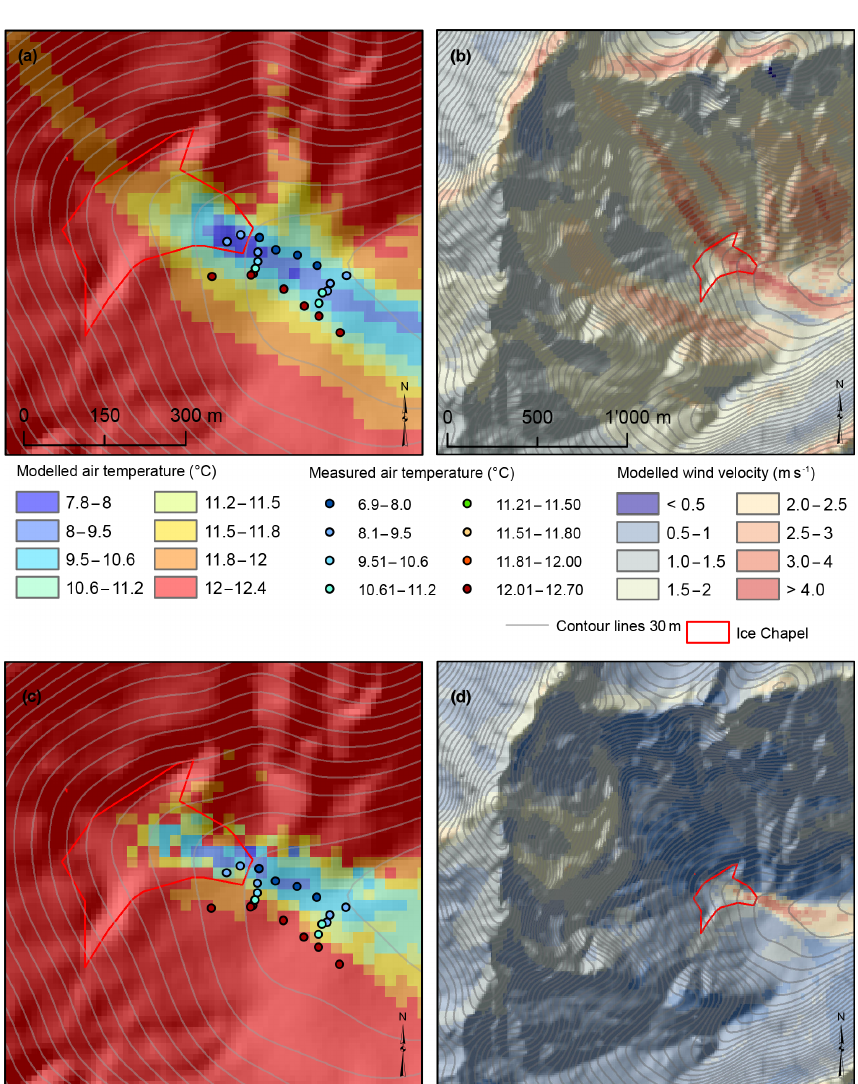
Figure 12. Air temperature and wind velocity fields modelled with the atmospheric model ARPS, initialized by a stable atmosphere (a, b) and by a neutral atmosphere (c, d) . Fields are shown for the first model level above ground with an average height of 2m above the ice field surface. Simulations were initialized at 12:00 and were run for an integration time of